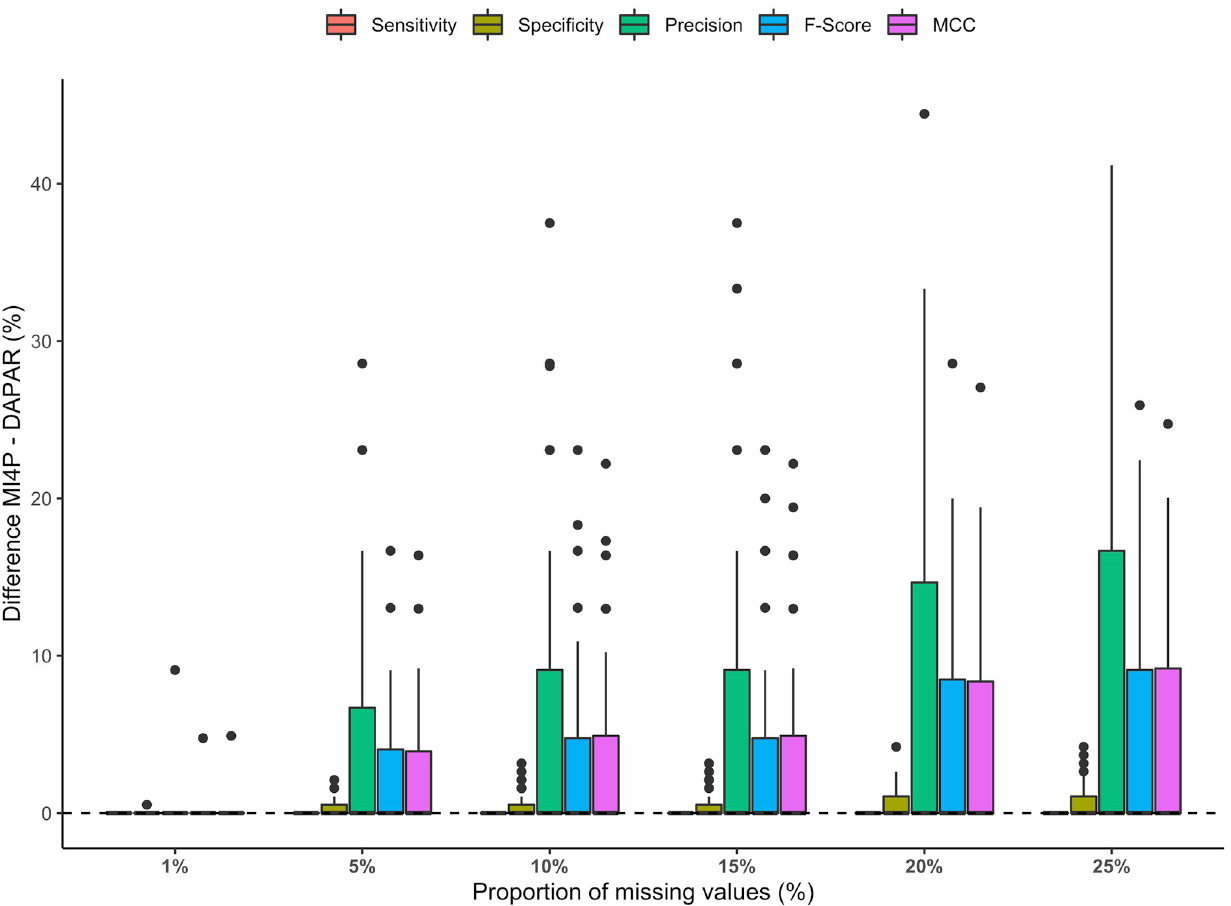
Fig 7. Distributions of differences in sensitivity, specificity, precision, F -score and Matthews correlation coefficient for the first MAR set of simulations. Missing values were imputed using the maximum likelihood estimation method.